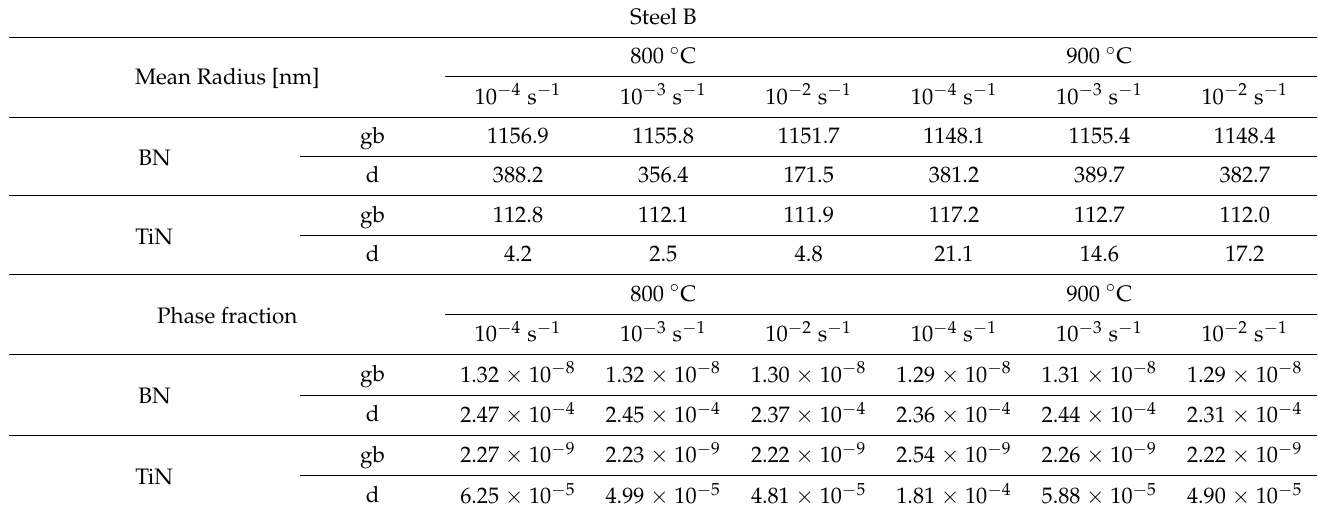
Table 3. Simulation results for the precipitation kinetics of steel B. Steel